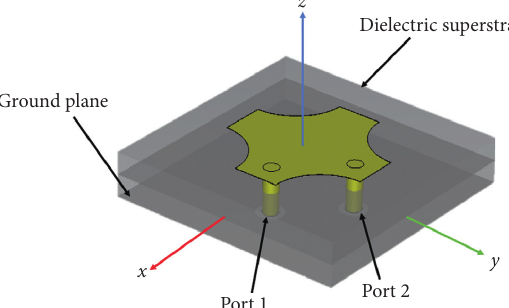
Figure 6: Patch element with angular circular cutouts of the 4 × 4 array configuration proposed in